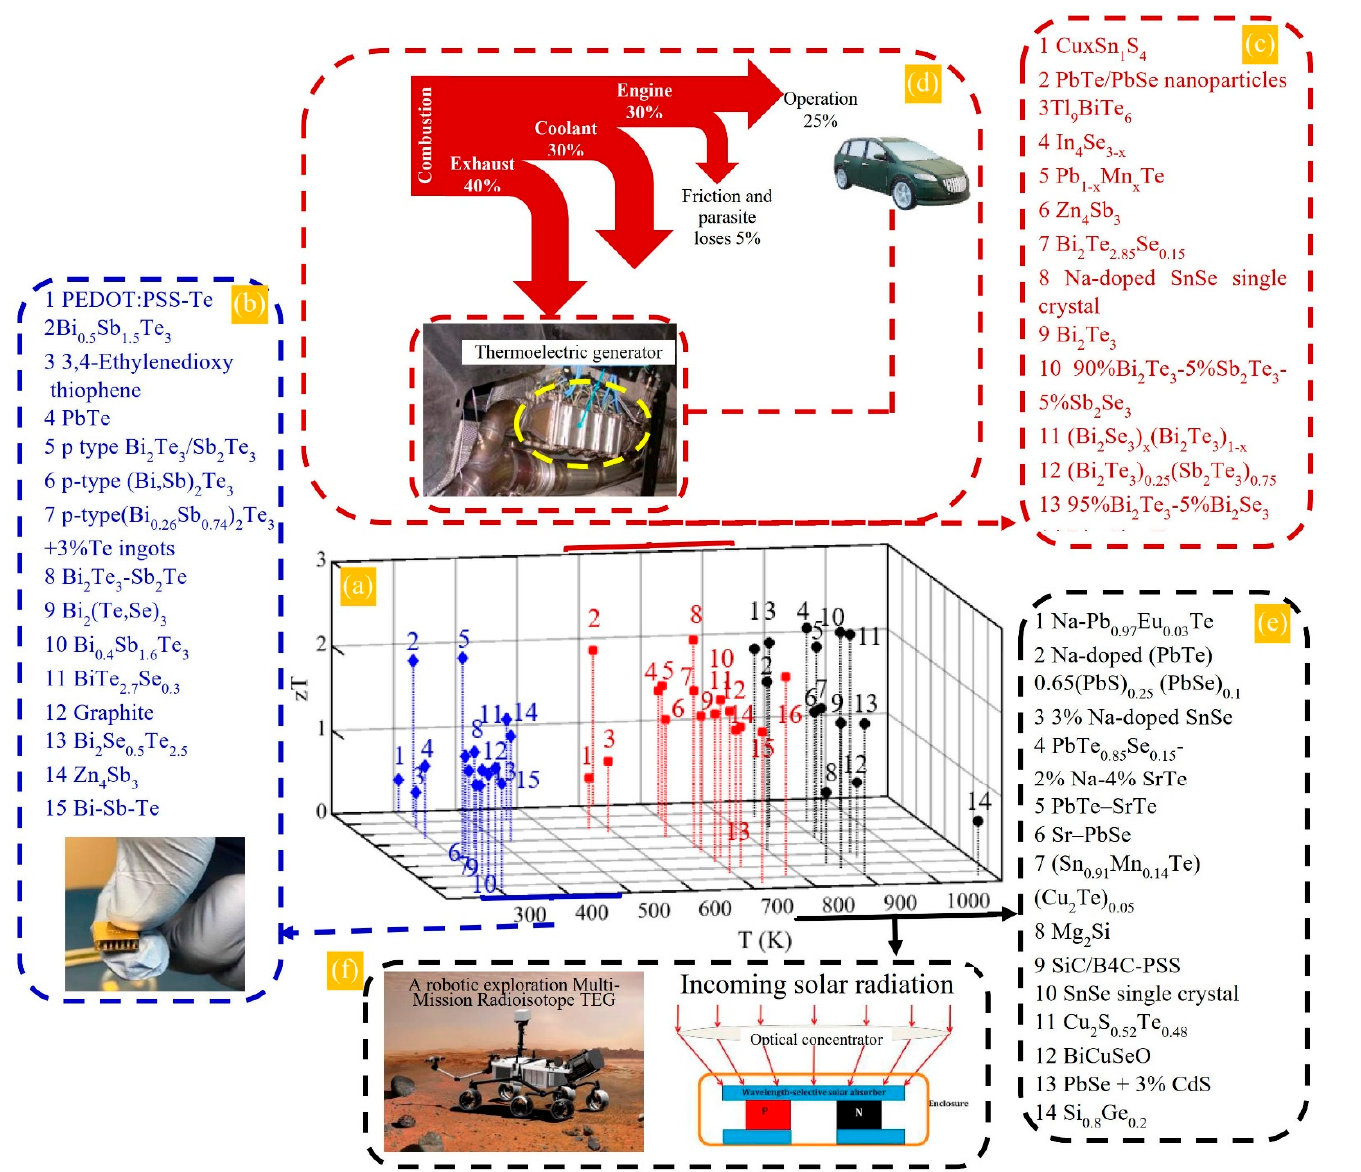
Figure 7. ( a ) Stem chart, which classifies the TE materials based on their optimum operating temperatures in three main intervals: low (Room temperature to 600 K), mid (600 to 850 K), and high (850 K and more) [49], ( b ) a list of TE compounds, and a TEG operating at room temperature, ( c ) illustrates the TE materials with the optimized application at medium temperatures, and ( d ) an application of TEGs in converting car exhaust heat into electricity [5,50], ( e ) represents the TE compounds with optimum performance at high temperatures, and ( f ) two examples of their applications by NASA [51], and Solar TEGs [52] (adapted from [8], with permission).